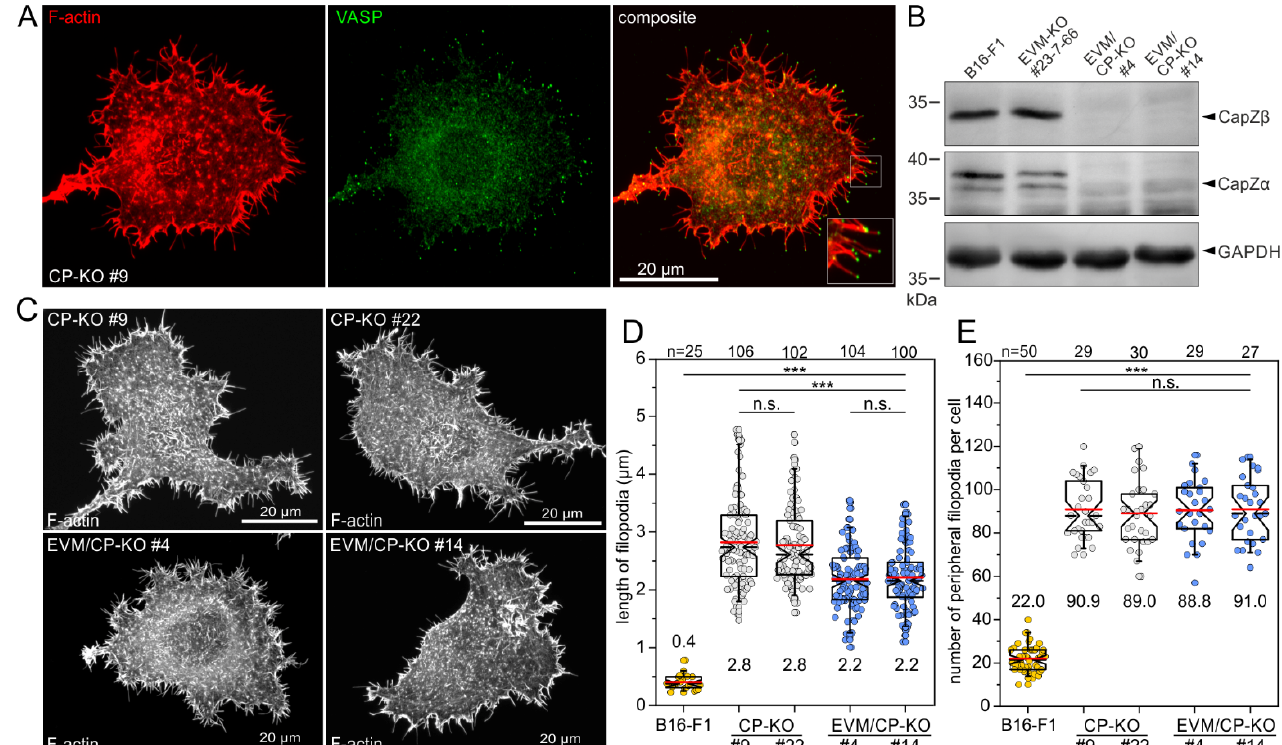
Figure 5. B16-F1 mutants continue to display massive filopodia formation even after combined loss of all Ena/VASP proteins and CP. ( A ) A CP-deficient B16-F1 cell stained for endogenous VASP and F-actin confirms localization of VASP at the distal tips of filopodia. Inset, enlarged image of boxed region. ( B ) Immunoblot confirming the elimination of CP-ß in two independent EVM-KO mutants (clones #4 and #14). Loss of the ß-subunit, in turn, led, again, to the almost complete loss of the CP- α - subunit. Loading control: GAPDH. ( C ) Morphologies of representative CP-KO and EVM/CP-KO mutant cells migrating on laminin and stained for the F-actin cytoskeleton with phalloidin. Note the continued formation of numerous filopodia in EVM/CP-KO cells. ( D ) Quantification of filopodia length in B16-F1 wild-type and derived CP-KO and EVM/CP-KO mutant cells. Note that B16-F1 cells, as shown in Figure 1B, primarily form microspikes and barely any filopodia that protrude beyond the periphery of the membrane. ( E ) Quantification of the number of peripheral filopodia in CP-KO and EVM/CP-KO mutant cells. ( D , E ) The boxes in box plots indicate 50% (25–75%) and whiskers (5–95%) of all measurements, with dashed black lines depicting the medians and arithmetic means highlighted in red. ( D ) Non-parametric Kruskal–Wallis test and Dunn’s Multiple Comparison test and ( E ) one-way ANOVA and Tukey Multiple Comparison test were used to reveal statistically significant differences between datasets. *** p ≤ 0.001; n.s.: not significant. n: number of filopodia ( D ) or cells ( E ) analyzed from three independent